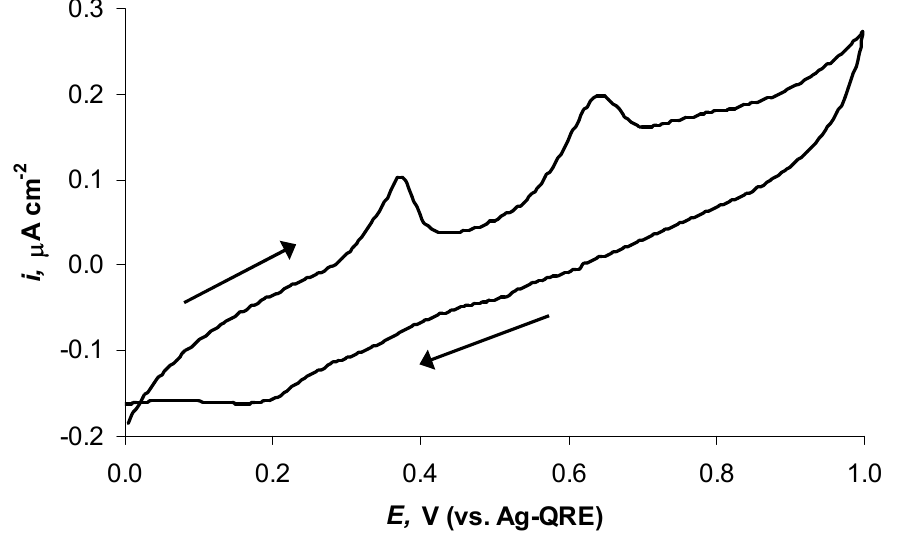
Figure 2. The cyclic voltammogram (CV) measured within the potential range of 0.00 V to 1.00 V and reverse at the potential sweep rate of 1.00 mV s − 1 . The second CV sweep is presented; the potential sweep directions are indicated in the figures with arrows.